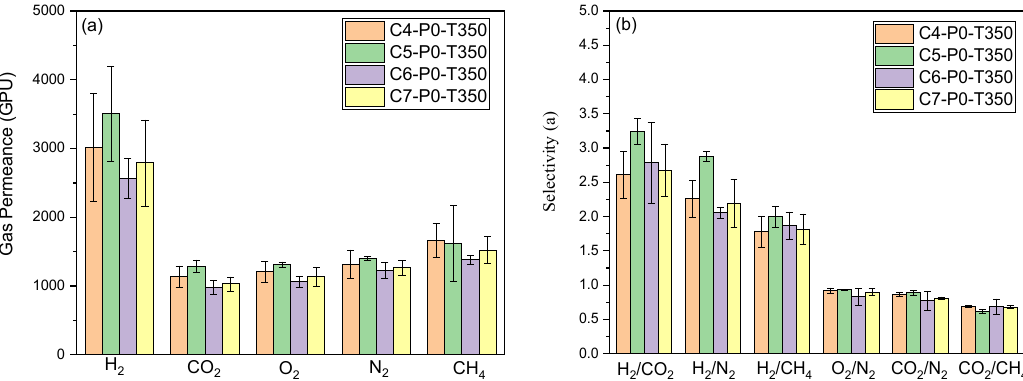
Figure 5. Gas separation performances obtained from resultant thermally rearranged (TR) membranes with different precursor concentrations. ( a : single gas permeance; b : selectivity of different gas pairs).